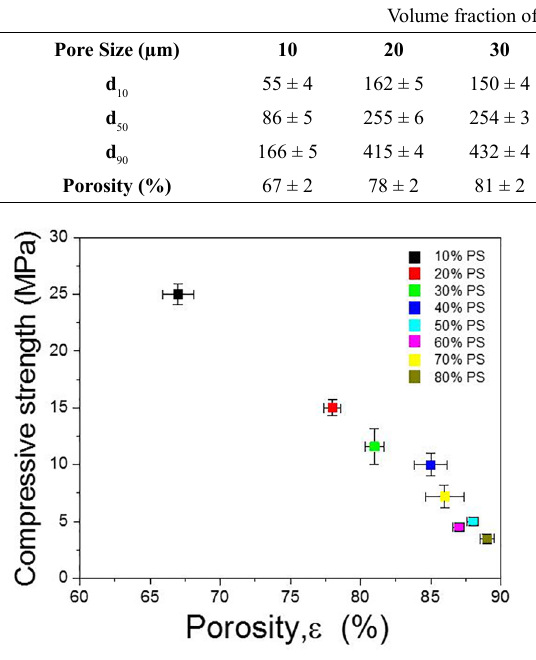
Figure 7. Compressive strength of fired (850 °C/30 min) vitrocrystalline foams as a function of